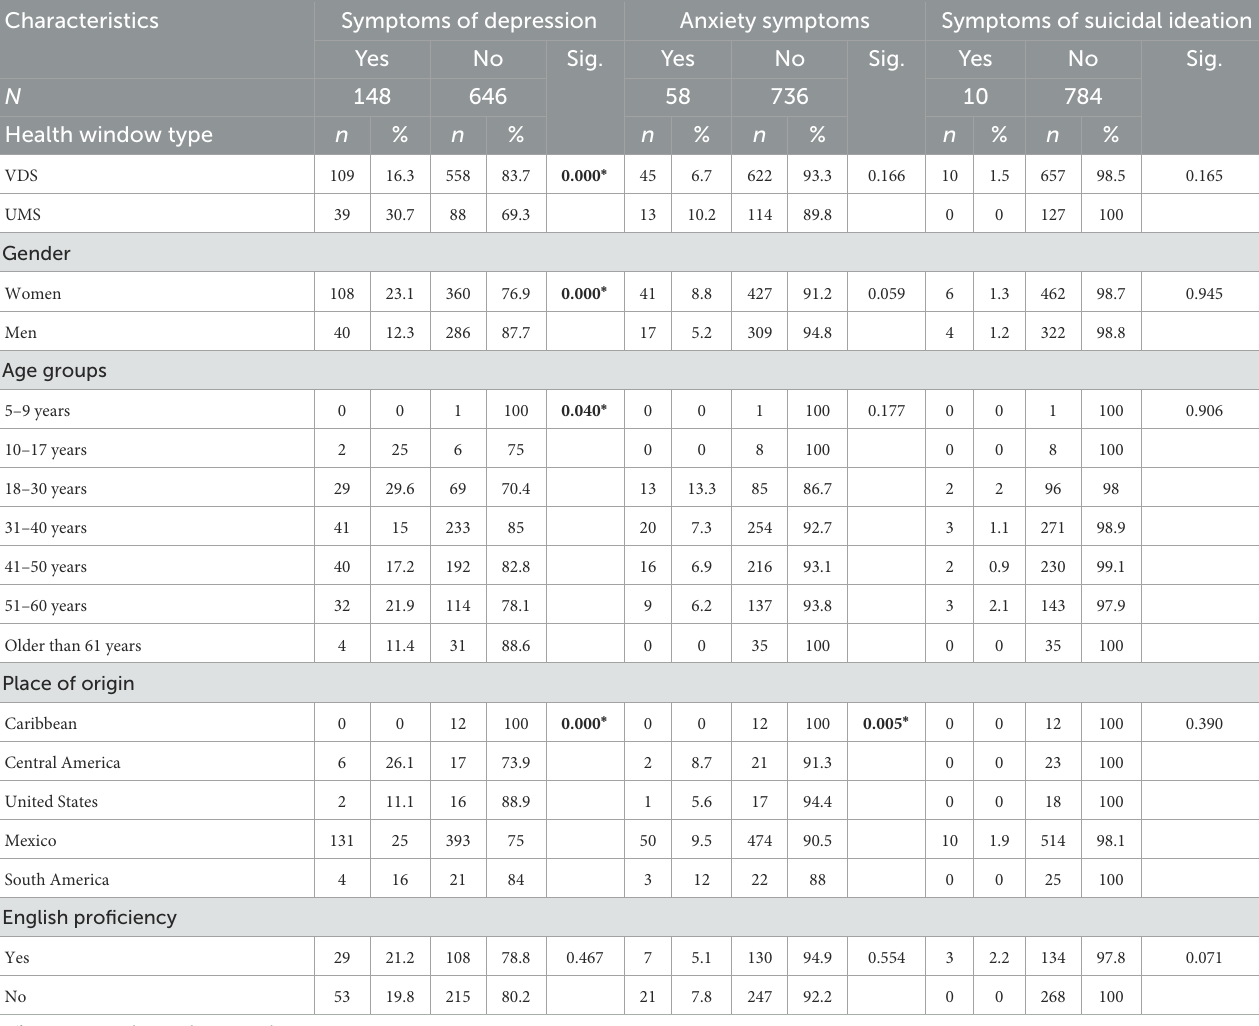
TABLE 2 Distribution of sociodemographic characteristics among the population with or without mental health symptoms/problems of depression, anxiety, suicidal ideation for screenings done at HW and MHU during 2021. Characteristics Symptoms of depression Anxiety symptoms Symptoms of suicidal